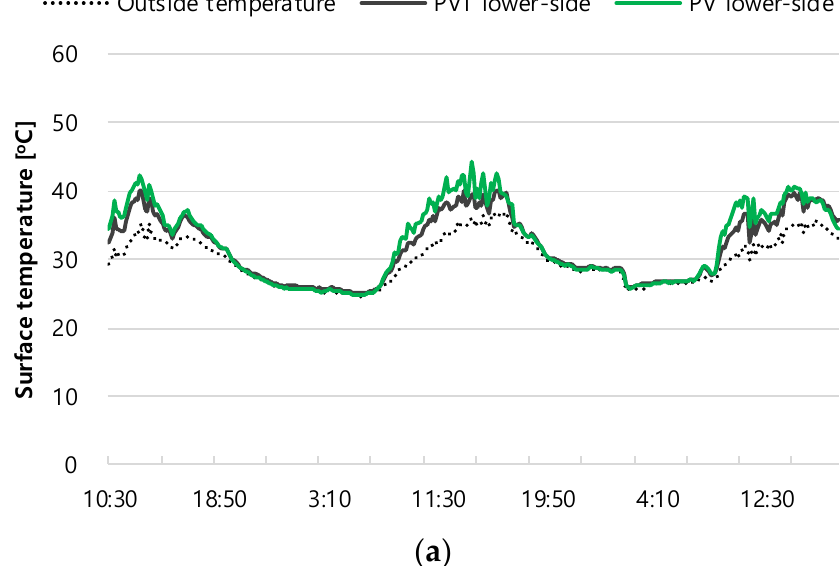
Figure 3. Upper surface temperature of the panels: ( a ) summer; ( b ) winter.